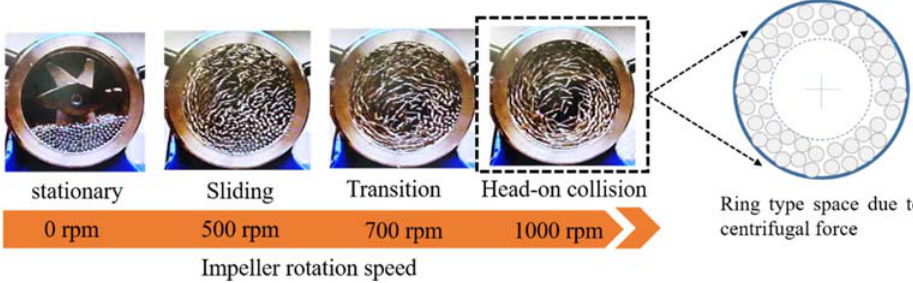
Figure 4. Ball ‐ to ‐ ball collision mode changes depending on the rotation speed of the impeller.